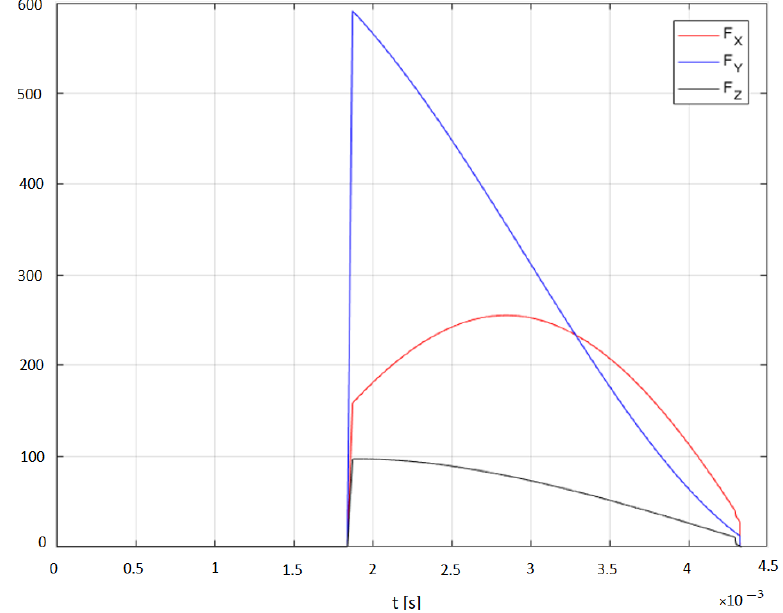
Figure 15. Predicted cutting forces.